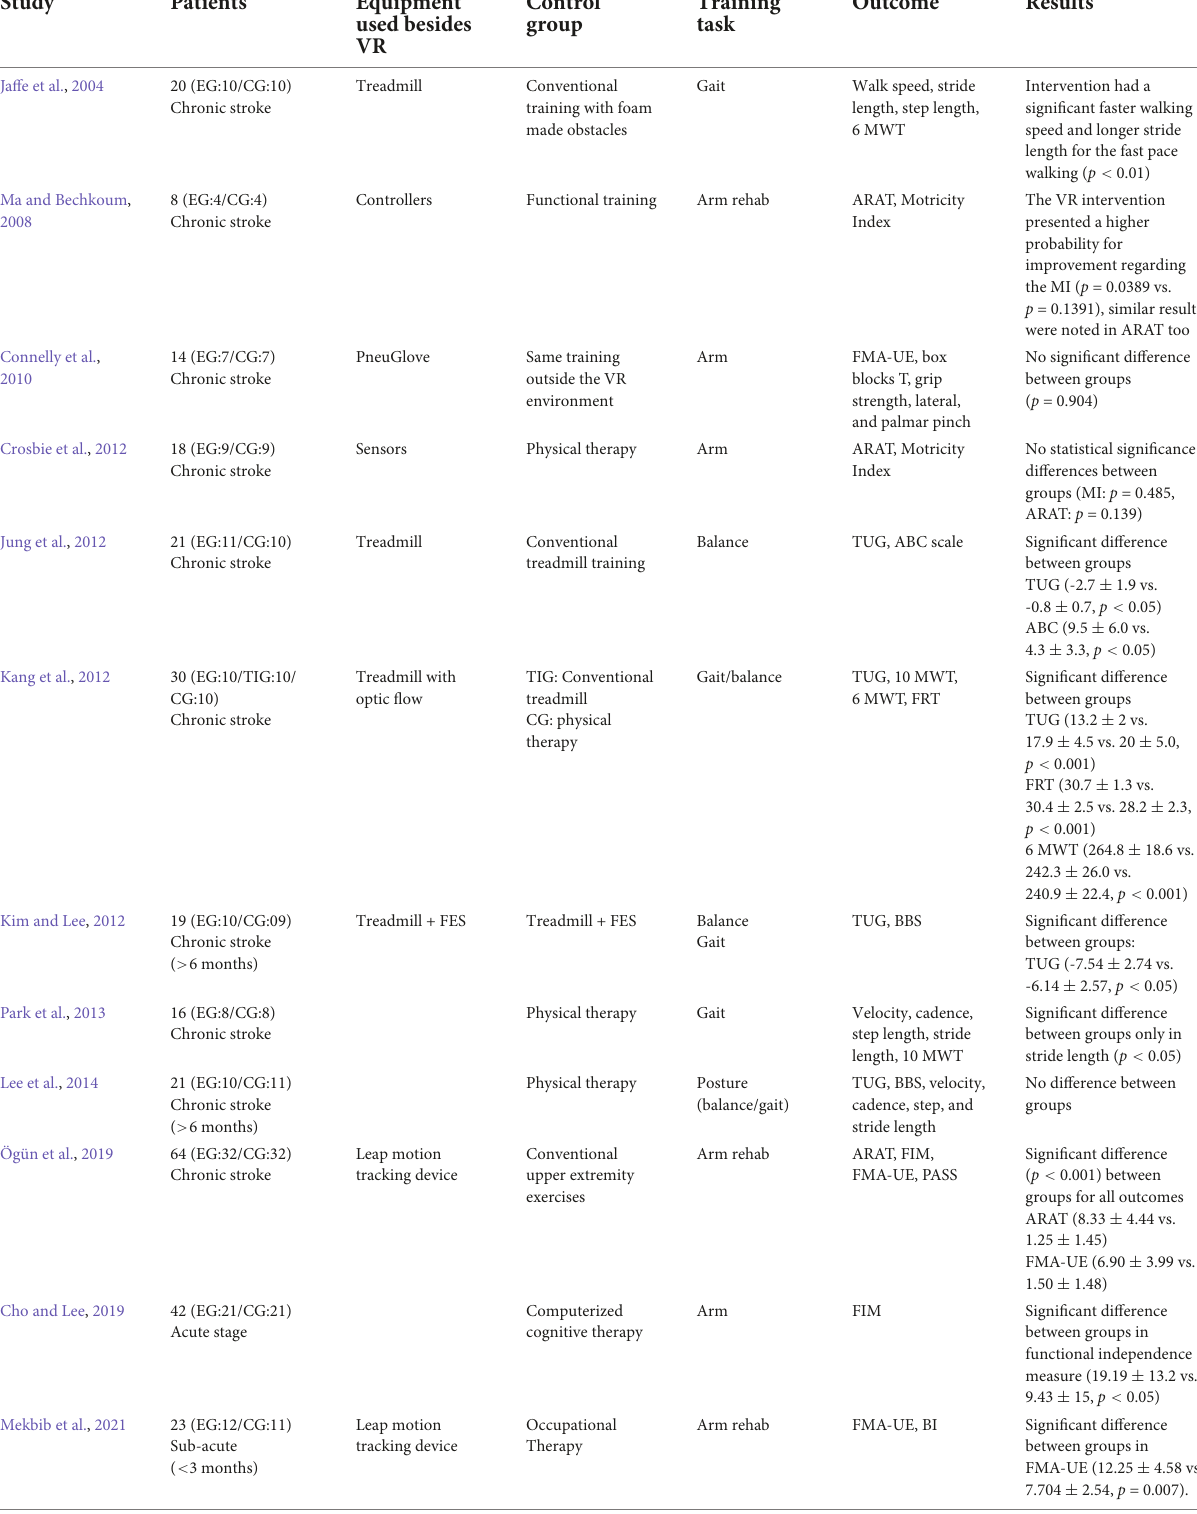
TABLE 1 Characteristics of all included